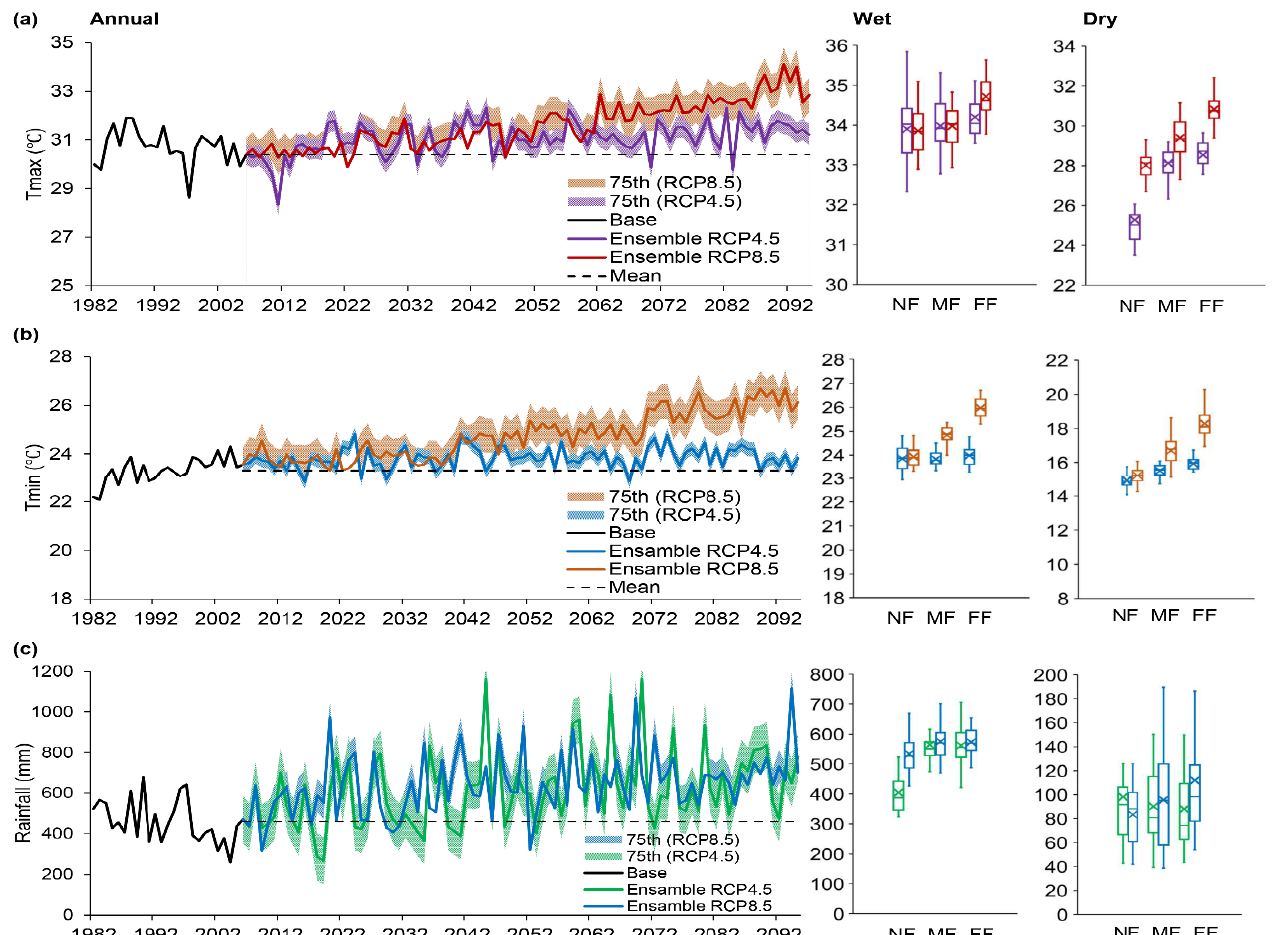
Figure 2. Temporal projections of ( a ) T max , ( b ) T min , and ( c ) rainfall in Ravi River Basin for climate change (RCP4.5 and RCP8.5) scenarios in the twenty-first century.